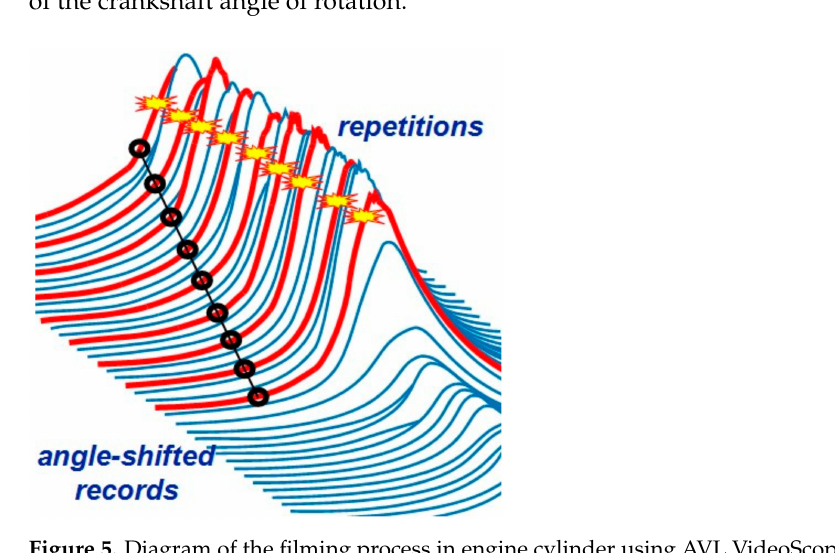
Figure 5. Diagram of the filming process in engine cylinder using AVL VideoScope 513D